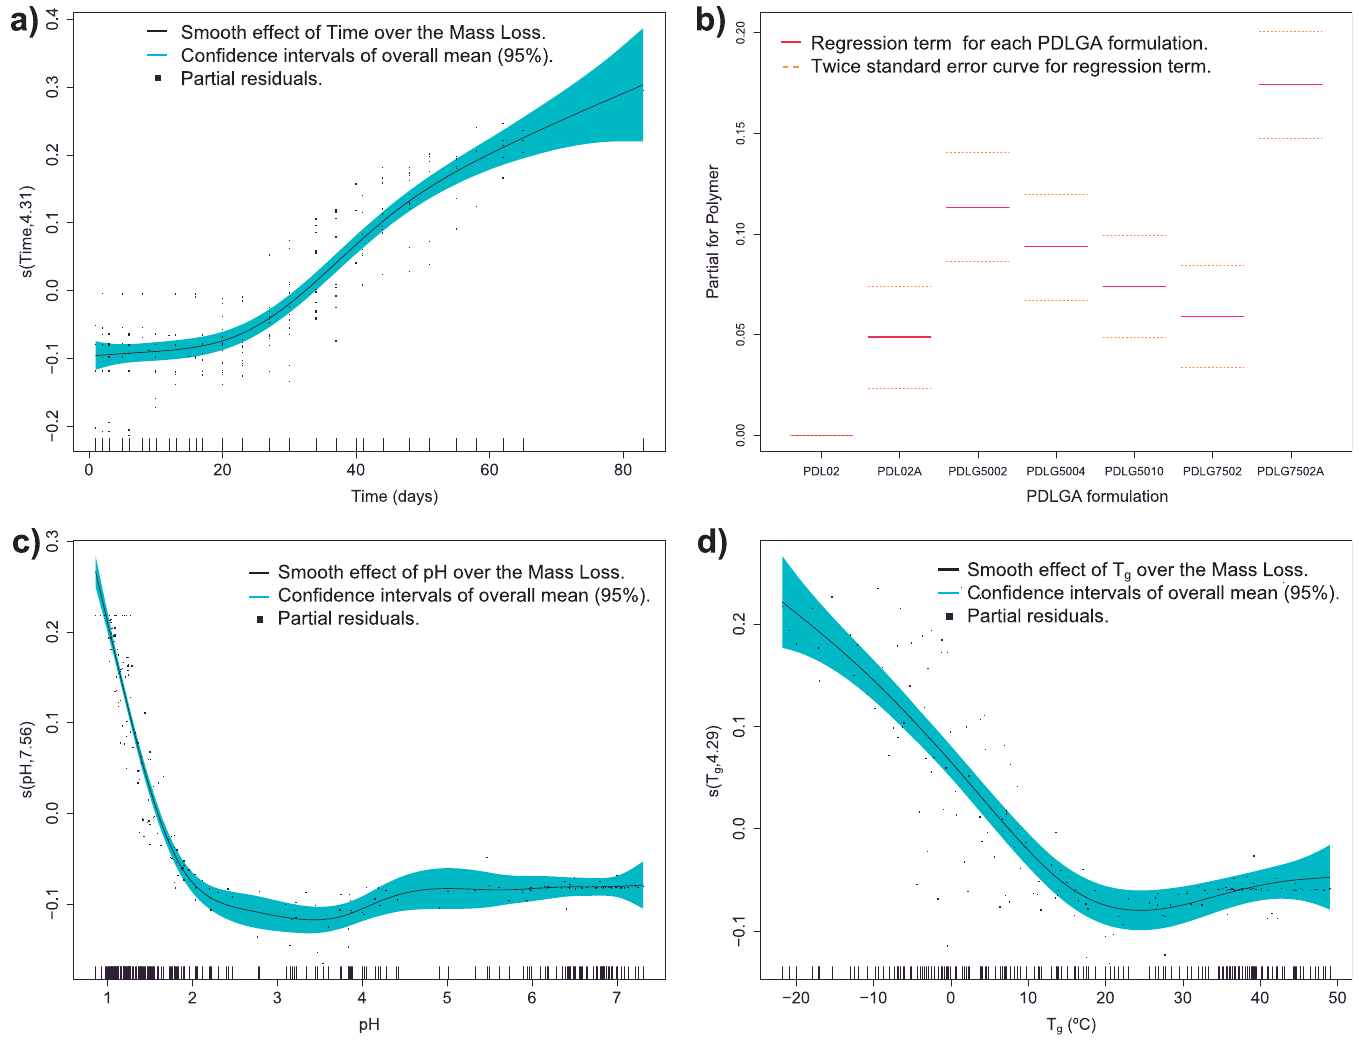
Fig 6. Smooth effects of time (panel a), and PDLGA formulation (panel b) over mass loss response corresponding to GAM1 model. Smooth function of pH when estimating mass loss (panel c) with the GAM2 model. Smooth effect of T g over the mass loss response (panel d) of GAM3 model.